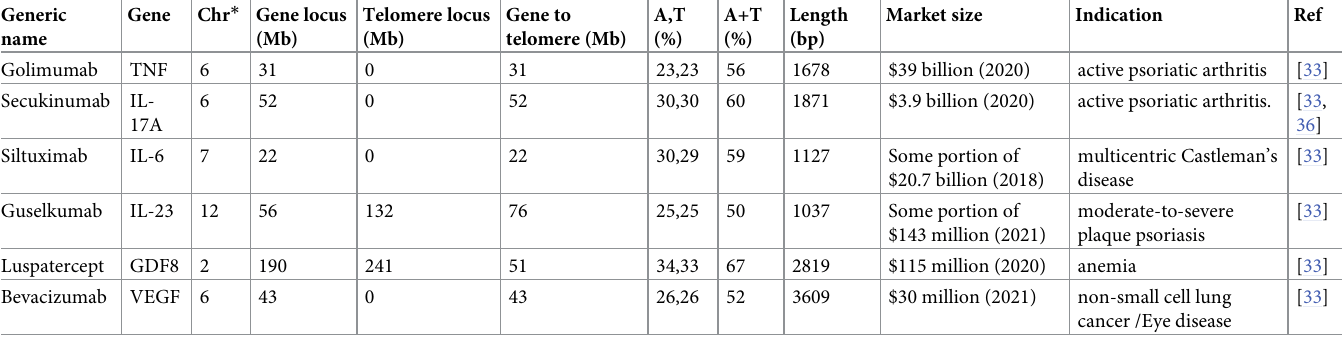
Table 2. Two factor characteristics of cytokines targeted by the FDA-approved